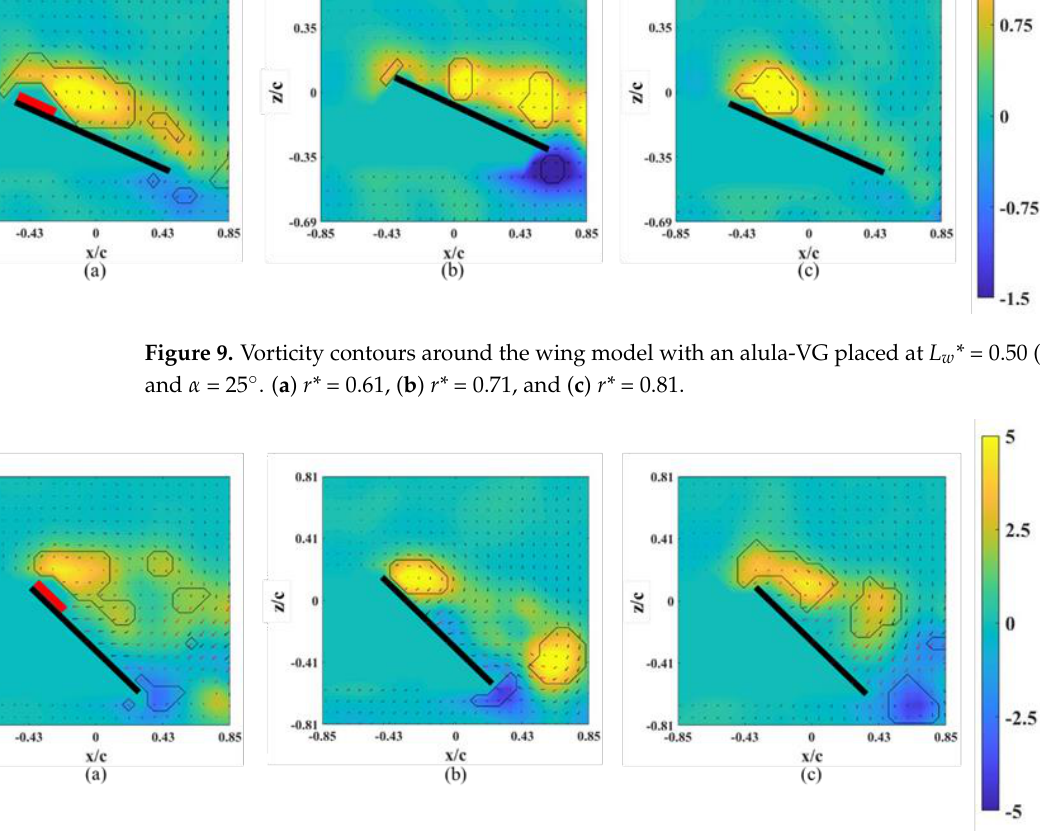
Figure 10. Vorticity contours around the wing model with an alula-VG placed at L w * = 0.50 ( r* = 0.62) and α = 45 ◦ . ( a ) r* = 0.61, ( b ) r* = 0.71, and ( c ) r* = 0.81. For the wing model with an alula-VG at L w * = 0.25, the spanwise distributions of Γ * and Γ LEV * are shown in Figure 11a. The value of the base wing model is shown in a solid symbol as the control group. At α = 10 ◦ , the usage of an alula-VG was not beneficial for the intensity of the vortex for both Γ * and Γ LEV * at every x-z plane. This is because the vortex induced by the alula-VG affected the spanwise vorticity flux and the spanwise pressure gradient, which weakened the strength of the LEV and reduced the value of circulation. At higher angles of attack ( α = 25 ◦ and 45 ◦ ), there were increases in the values of Γ LEV * and Γ * in the region near the alula-VG. Toward the outboard region of the wing, the bursting of the LEV and the higher local Ro due to the revolving motion gradually diminished the effect of the